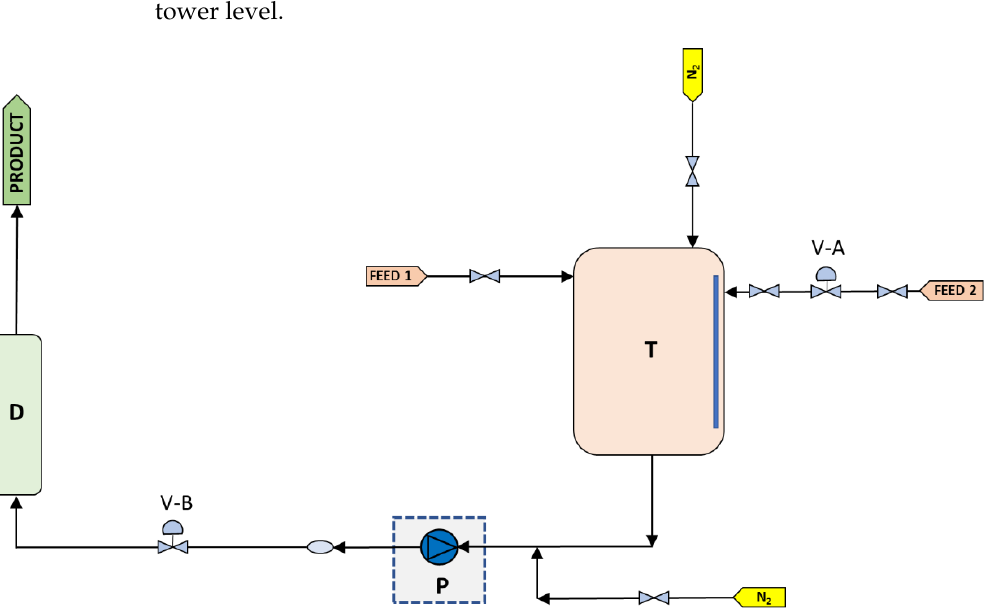
Figure 3. Work process flowchart at the polyol/polyglycol plant. The impeller was mounted in pump P. T: reaction tank, D: distillation column, V-A and V-B: fail-open valves.